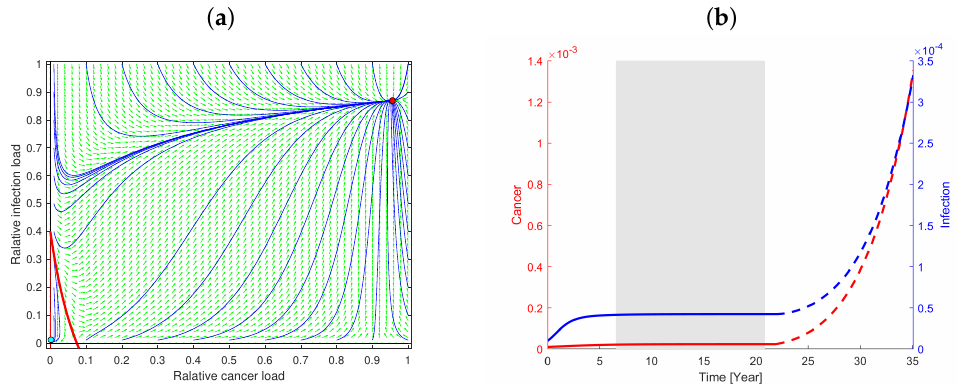
Figure 3. Cancer-infection-immune dynamics. Populations are normalized by their carrying capaci- ties. ( a ) The phase plane with relative cancer size on first axis and relative infection burden on second axis. Circles, red for the full-blown disease state (to the upper right) and magenta for the dormant state (to the lower left) indicate the two stable co-existing steady states. Notice that the dormant state has very low but non-vanishing levels of malignant cells and infection. The solid blue curves are solution curves evolving over time toward one of the stable steady states. Green arrows indicate the flow direction at any point as these are tangent to the solution curves of Equation (6). The phase plane is divided into two regions by the red curve (the separatrix) depending on which stable steady state is approached. ( b ) The red curve is cancer progression while the blue curve is the progression of infection. Single mutations may be eliminated for sufficiently strong immune responses. If the immune response is less strong, the cancer and infection will start growing. For small times, the growth of both cancer and infection is logistic and each approaches an equilibrium (grey region). Thereafter, the exhaustion of cancer specific cytotoxic T-cells is imposed at year 22 (stipulated curves in right white region), which enforces the cancer and infection to escape. The exhaustion is included by allowing active cytotoxic T-cells to become inactivated with an exhaustion rate. As a result, the three E’s of immunoediting follows from the model. The full curves before escape may not cause symptoms but the stipulated part of the curves will sooner or later result in diagnosable conditions as these will continue increasing toward a value near 1 (not shown). However, the degree of exhaustion determines the escape growth